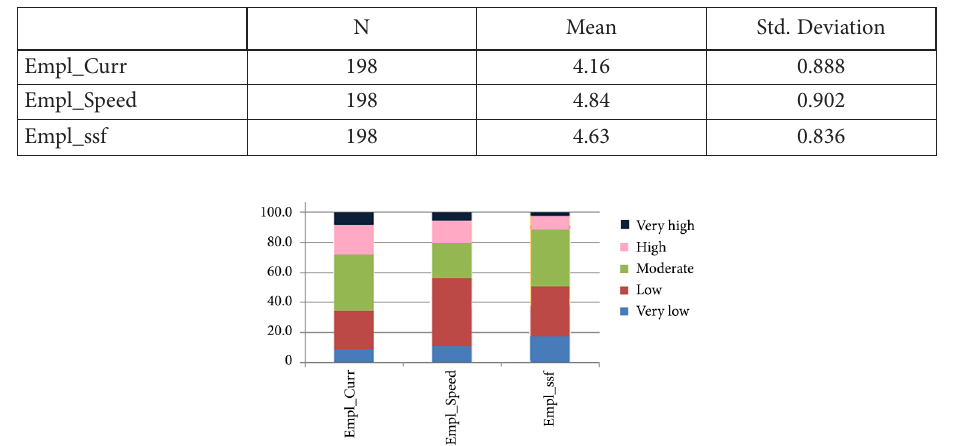
Table 5. Descriptive statistics for the variable employees’ access to information